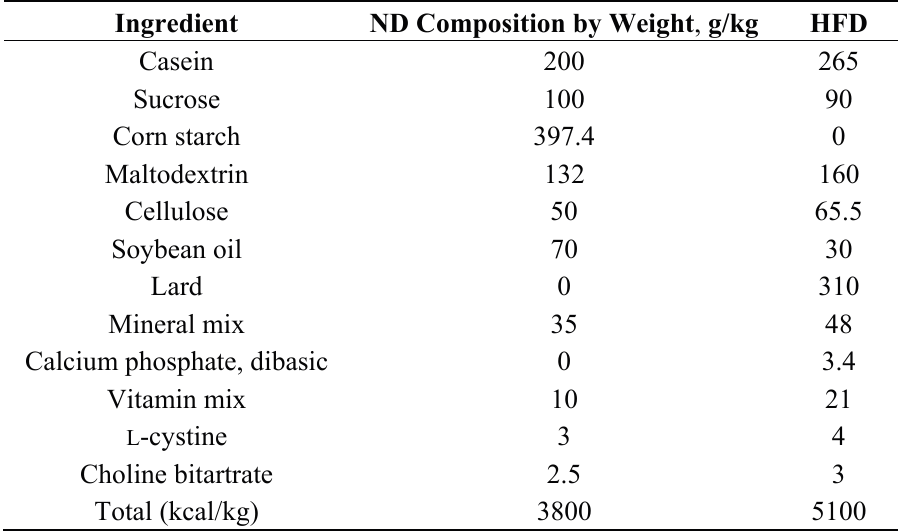
Table 2. Compositions of normal diet (ND) and high fat diet